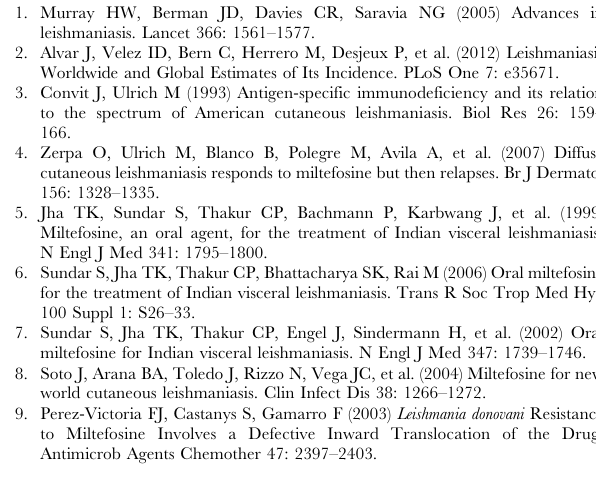
Figure S1 In vitro infectivity of L. amazonensis M2269, 2506 and MF150.3-1. BMDM were infected with stationary phase promas- tigotes for 3 h at 33 u C. Non-internalized parasites were removed by washing with warmed PBS. After 72 h, cells in 24-well chamber slides were fixed in methanol, stained and infected macrophages and amastigotes were determined by counting 100 cells. The average 6 standard deviation of three independent experiments is shown. (A) Percentage of infected macrophages in infections initiated with a ratio of 5, 10 or 20 parasites/macrophage. (B) Number of amastigotes per infected macrophage in infections as in (A). Figure S2 Characterization of MF150.3-1 lines isolated from infected mice treated or not with MF [MF150.3 clone 1 (MF) and MF150.3 clone 1 (NT) respectively]. MF150.3-1 lines were isolated from infected footpads 8 weeks post-infection. Amastigotes